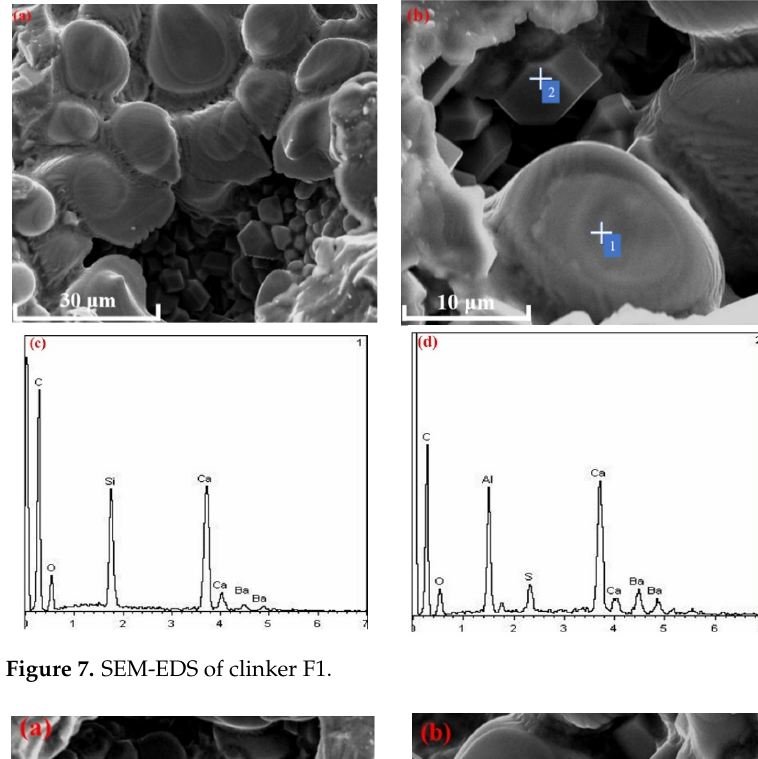
Figure 7. SEM-EDS of clinker F1.